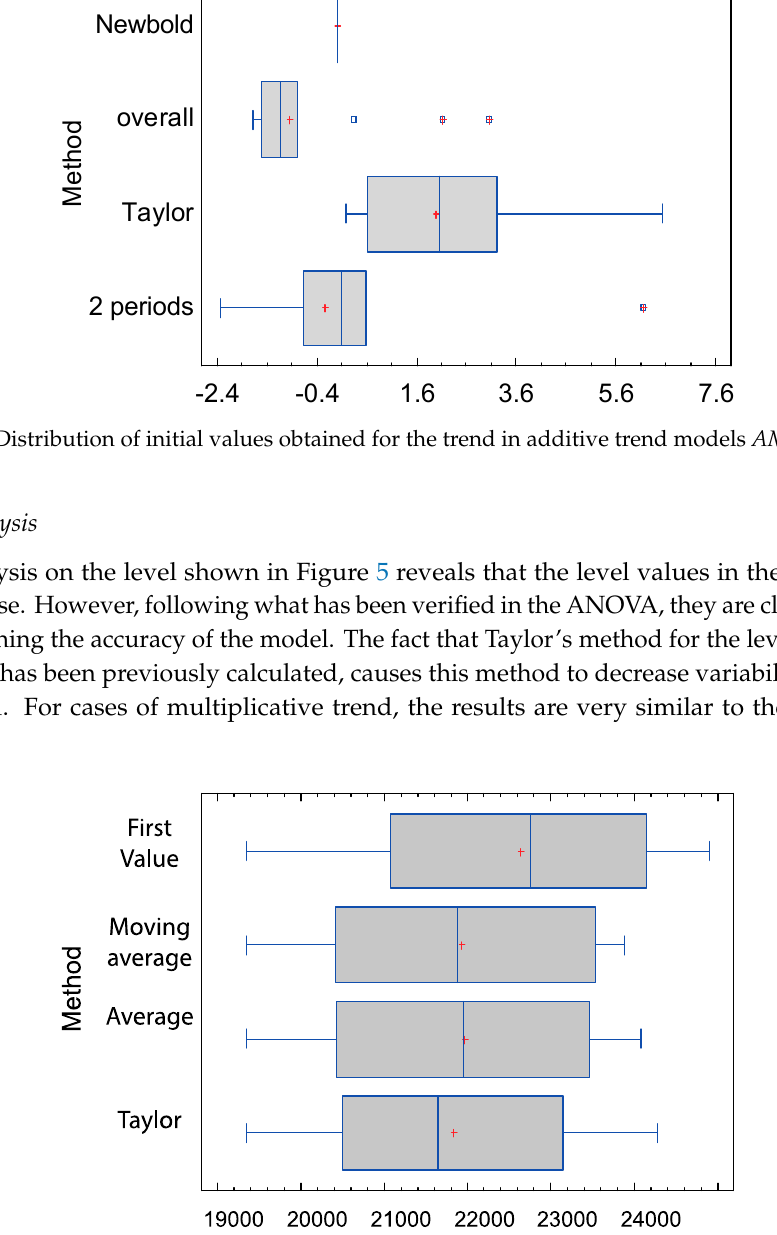
Figure 5. Distribution of the initial values obtained for the level in the additive trend models 𝐴𝑀𝐶 (cid:2870)(cid:2872),(cid:2869)(cid:2874)(cid:2876) y 𝐴𝐴𝐶 (cid:2870)(cid:2872),(cid:2869)(cid:2874)(cid:2876) .